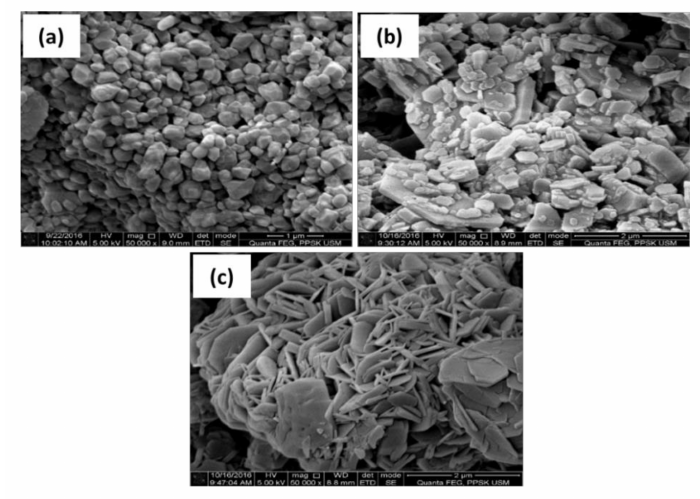
Figure 3. FESEM images of CaCO 3 in di ff erent solvents: ( a ) ethanol; ( b ) methanol; and ( c ) propanol. Table 2. BET surface area and average pore diameter analyses of CaCO 3 in di ff erent organic solvents. Solvent Surface Area (m 2 / g) Propanol